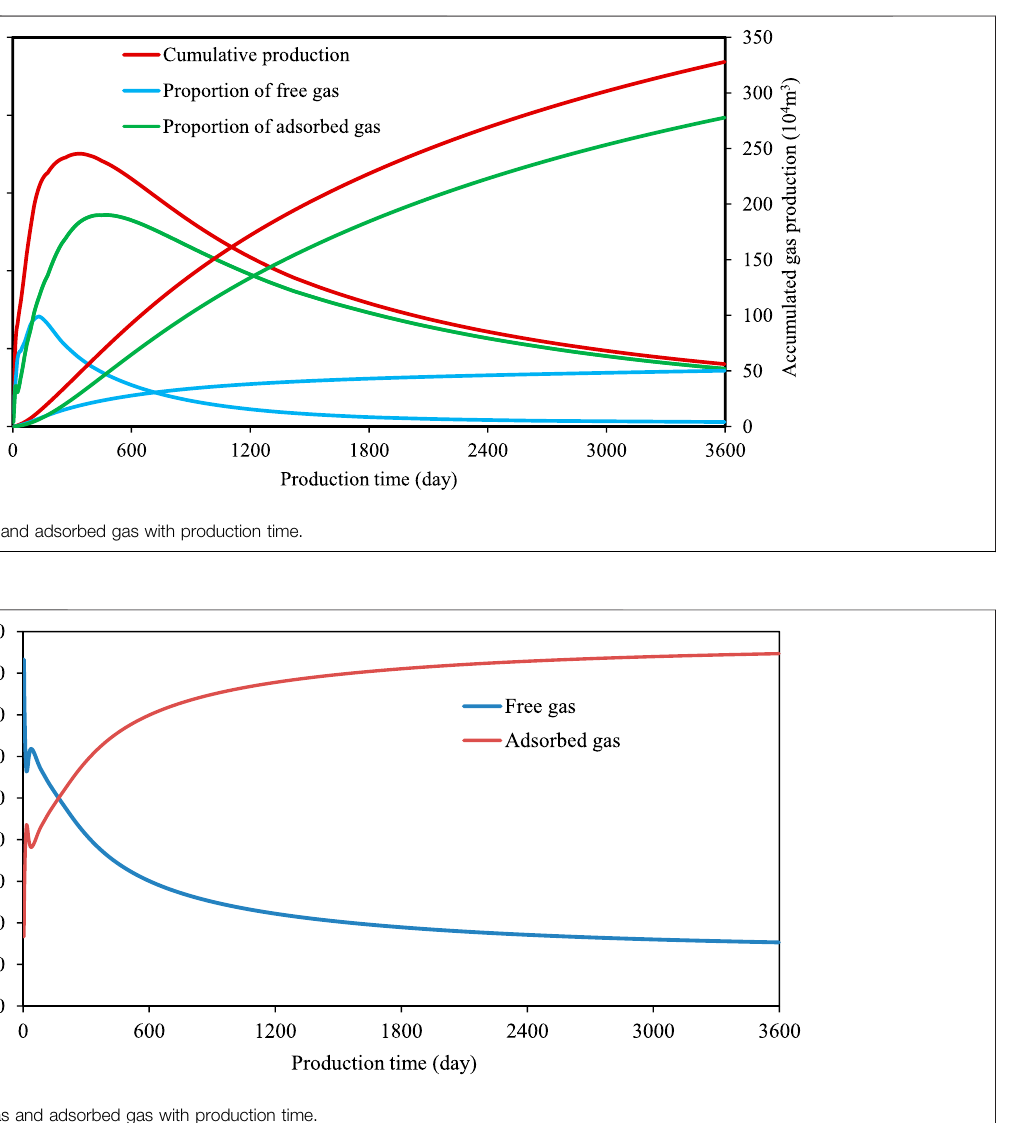
FIGURE 4 | Proportion of free gas and adsorbed gas with production time.